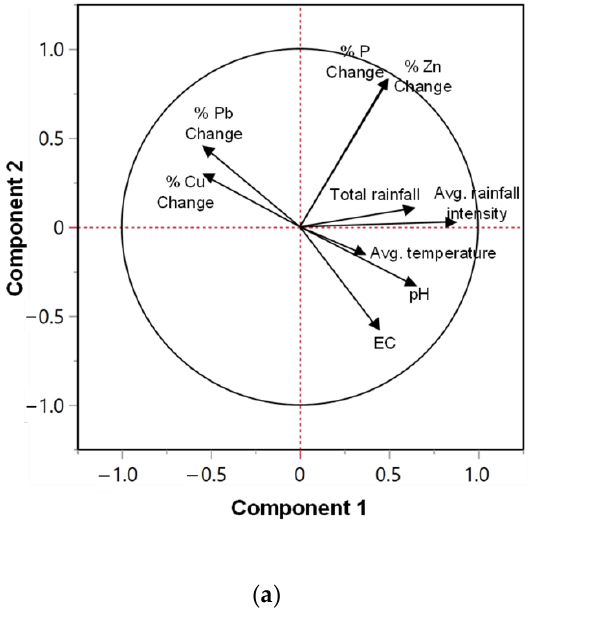
Figure 7. Principal component loading plots for ( a ) dissolved concentrations and ( b ) total concen- trations.